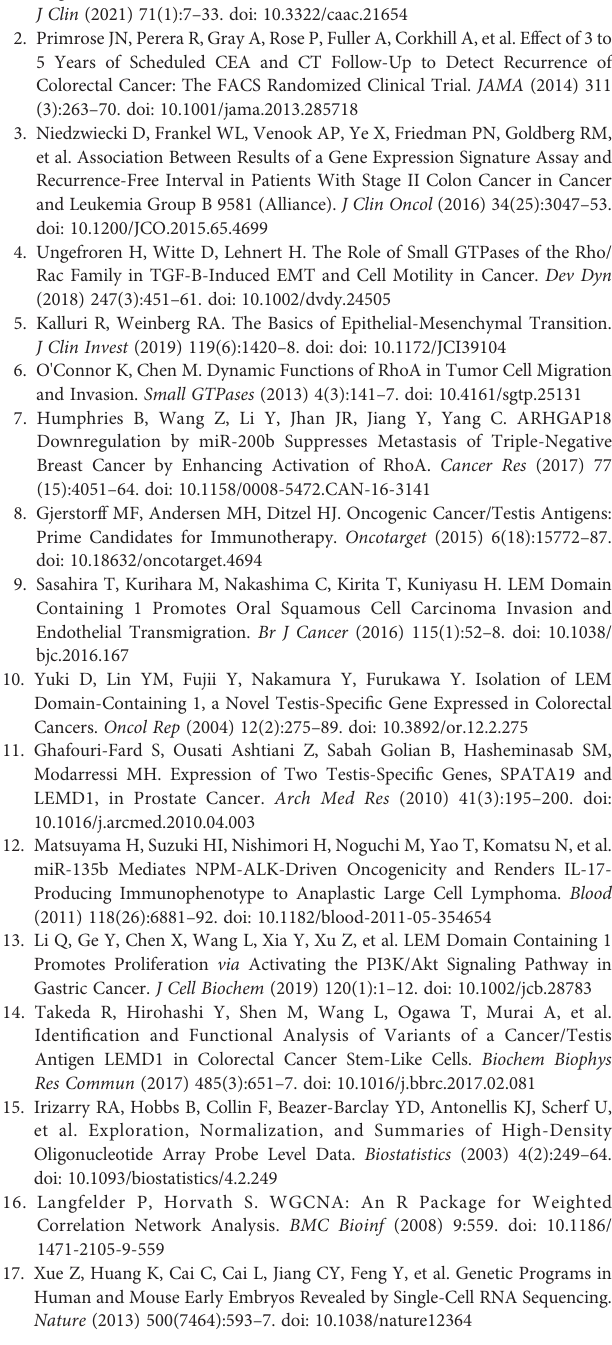
in the TCGA database according to different T stage; (C) patients with low expression of LEMD1 have shorter OS; (D) LEMD1 expression in 34 CRC cell lines in GSE97023.